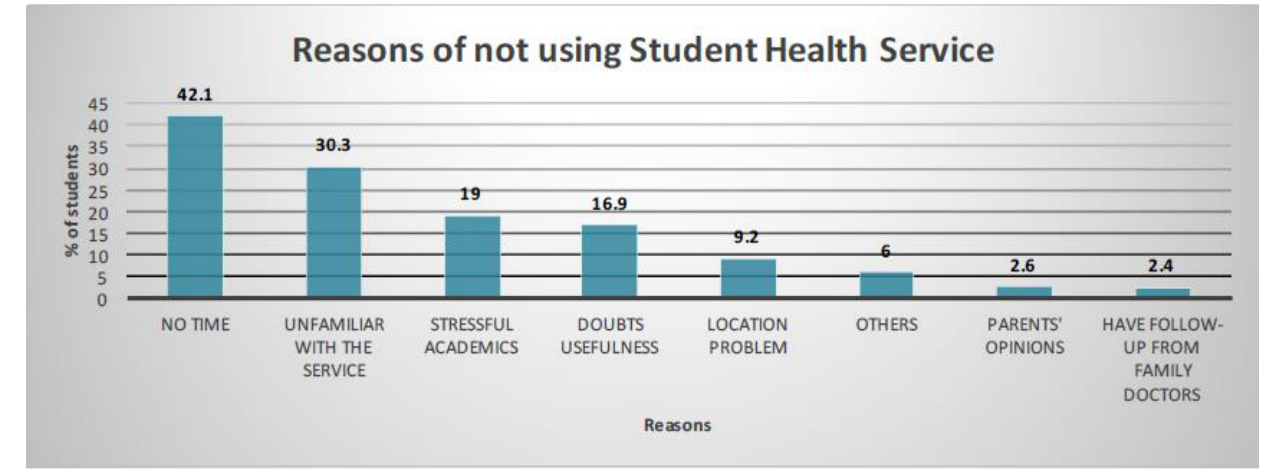
Figure 4. Reasons for not utilising Student Health Services.